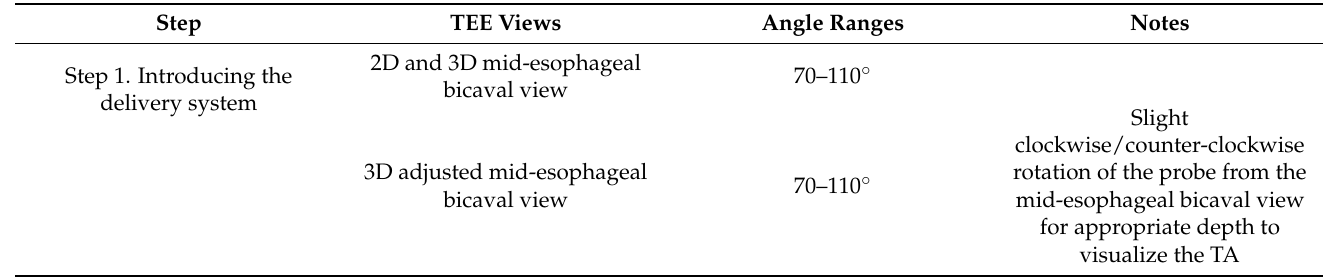
Table 1. Summary of the echocardiographic protocols for the step-by-step guidance of K-Clip